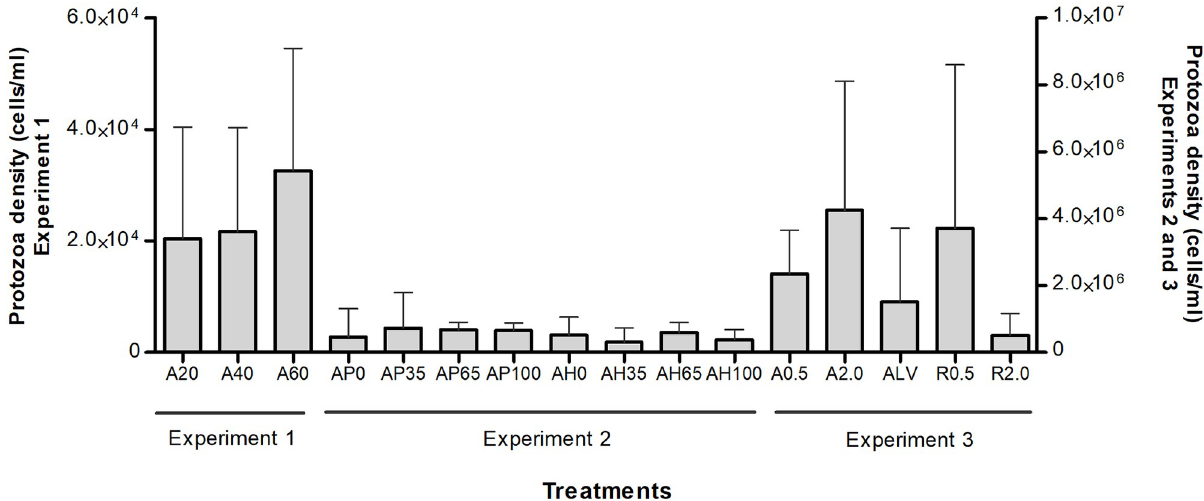
Fig 1. Total density of rumen ciliate protozoa. Total density of ciliates (arithmetic mean and standard deviation) in the 86 lambs rumen samples, grouped by treatments and by the experiments.